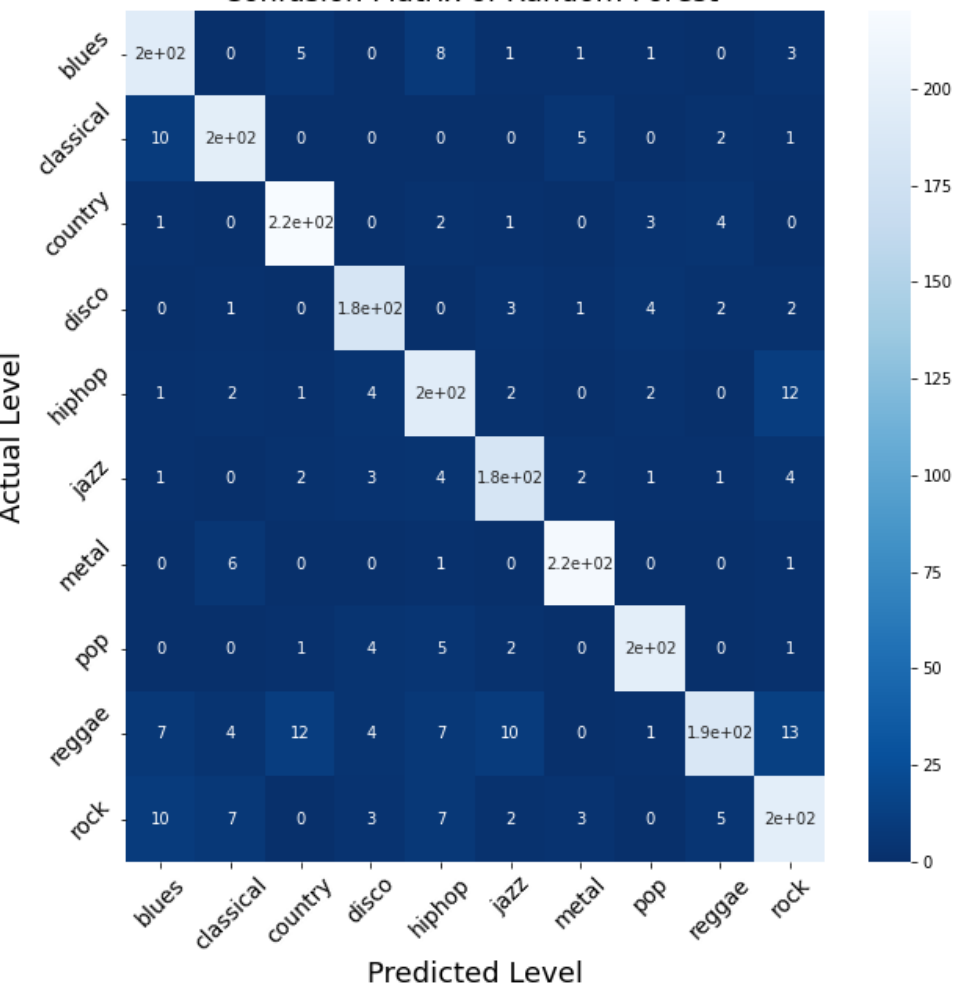
Figure 12. Visualisation of music genre classification results (testing samples). Table 5. Correctly (true positive) and incorrectly (false negative or false positive) classified music samples (testing samples) for each music class by the developed random forest